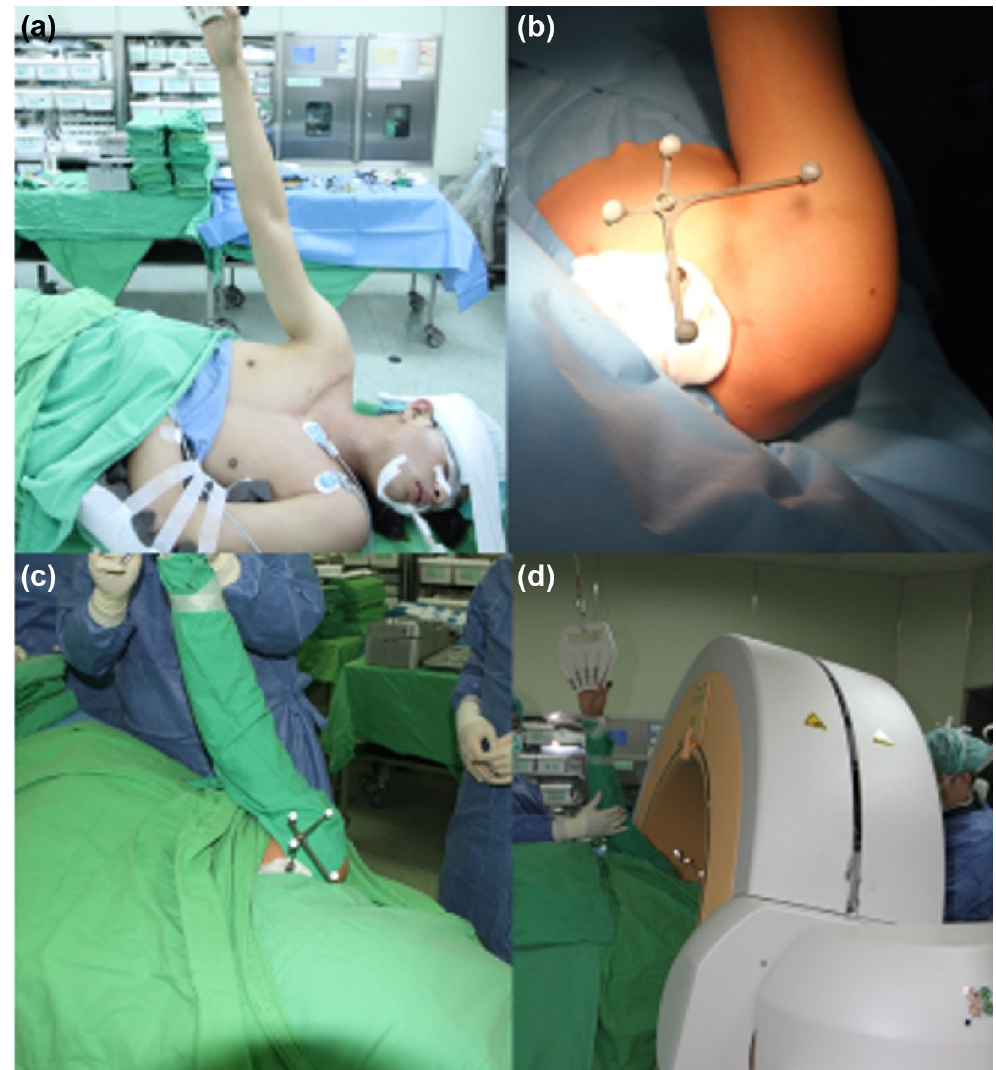
draping are performed as in traditional shoulder arthroscopy surgery. The mid-third clavicle is exposed for fixation of navigation reference frame through a 1-cm incision (Fig 2b). The patient is covered with a sterilized drape (Fig 2c), and the O-arm is positioned around the patient at a 30˚ tilt to avoid contacting the sterilized arm (Fig